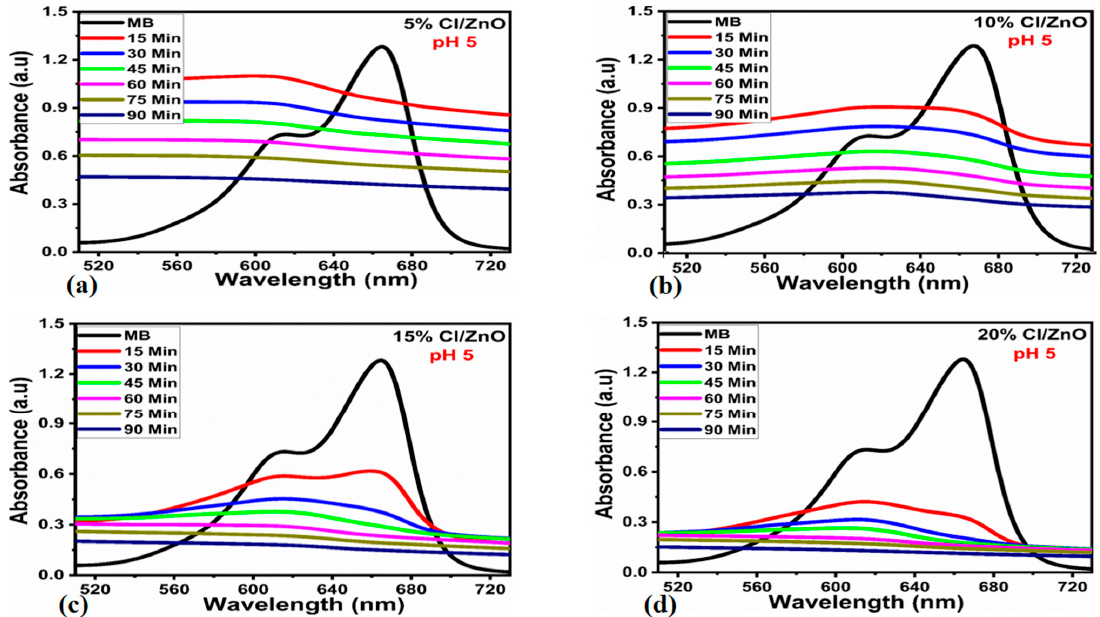
Figure 6. ( a – d ) UV–Vis absorbance spectra monitoring the concentration of MB after 15 intervals of time for 5%, 10%, 15% and 20% Cl − -doped ZnO at pH 5, respectively.